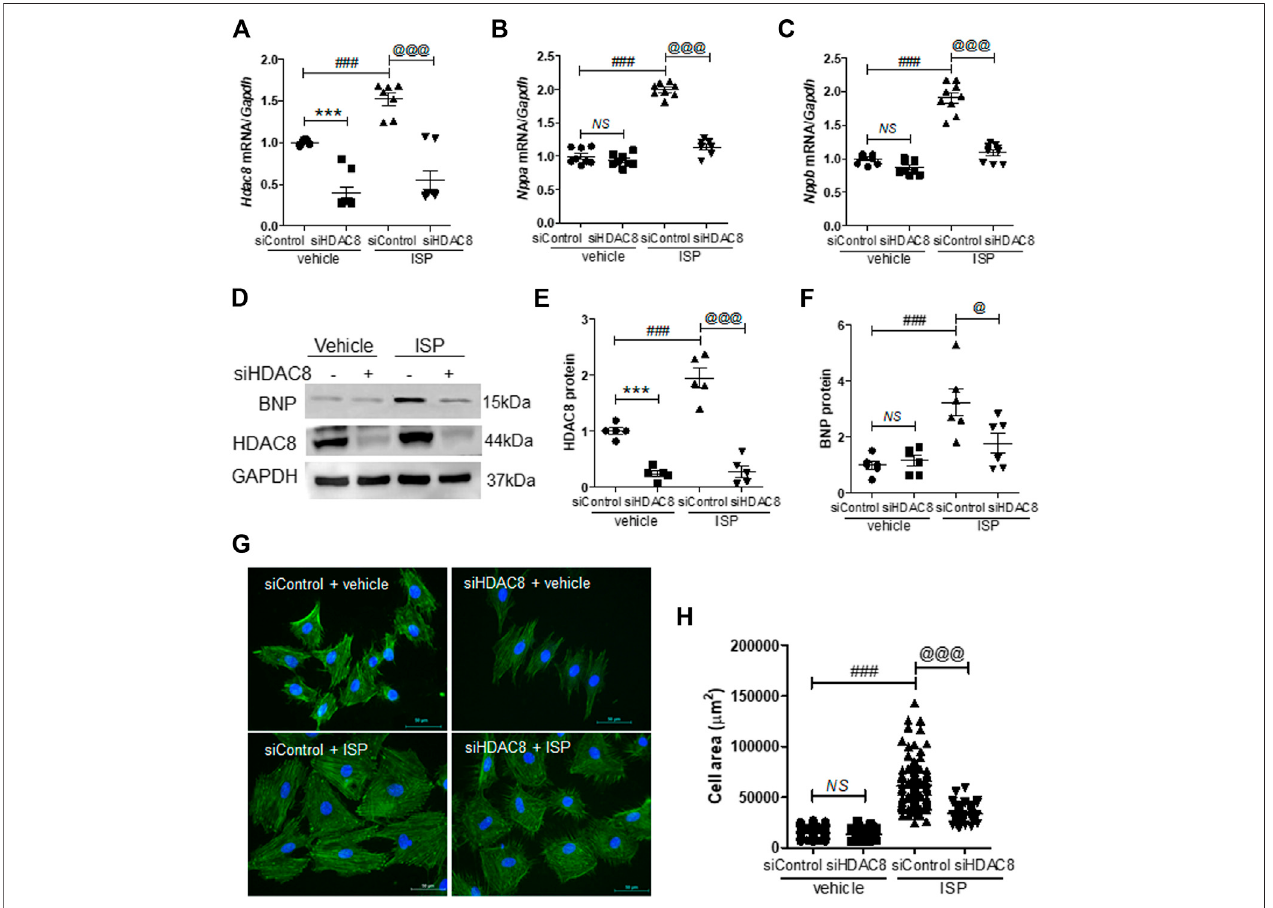
FIGURE 5 | Knockdown of HDAC8 reduces isoproterenol-induced cardiomyocyte hypertrophy in H9c2 cells. H9c2 cells were transfected with control or HDAC8 siRNA and then stimulated with isoproterenol (10 μ M) for 9 h (A – C) mRNA expression levels of Hdac8, Nppa, and Nppb in these cells ( n (cid:2) 8 – 9). *** p < 0.001; ### p < 0.001; @@@ p < 0.001. NS (cid:2) not signi fi cant (D-F) Representative western blot images (D) and quanti fi cation of HDAC8 (E) and BNP (F) protein levels ( n (cid:2) 5 – 6). *** p < 0.001; ### p < 0.001; @ p < 0.05 and @@@ p < 0.001 (G) Phalloidin-stained cells transfected with control or HDAC8 siRNA and then treated with isoproterenol (H) Quanti fi cation of cell size ( n (cid:2) 100 – 116). ### p < 0.001; @@@ p < 0.001. NS (cid:2) not signi fi cant. Data are presented as mean ± S.E. Statistics: one-way ANOVA followed by Bonferroni post hoc